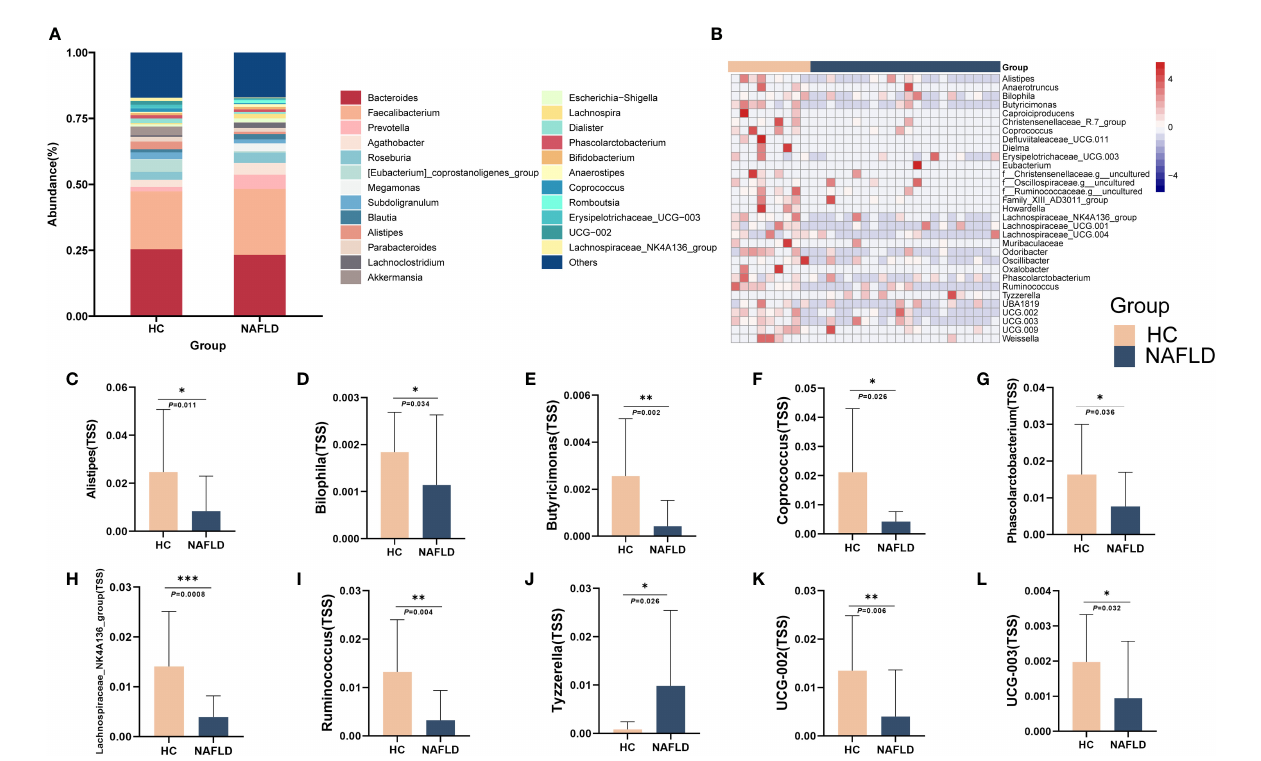
FIGURE 5 Altered intestinal fl ora abundance at genus level was observed in NAFLD. (A) The abundance percentages of HC and NAFLD groups at the genus level. (B) The heatmap of some of the intestinal fl ora genera with differences between HC and NAFLD. (C-L) Comparison of Alistipes , Bilophila , Butyricimonas ,